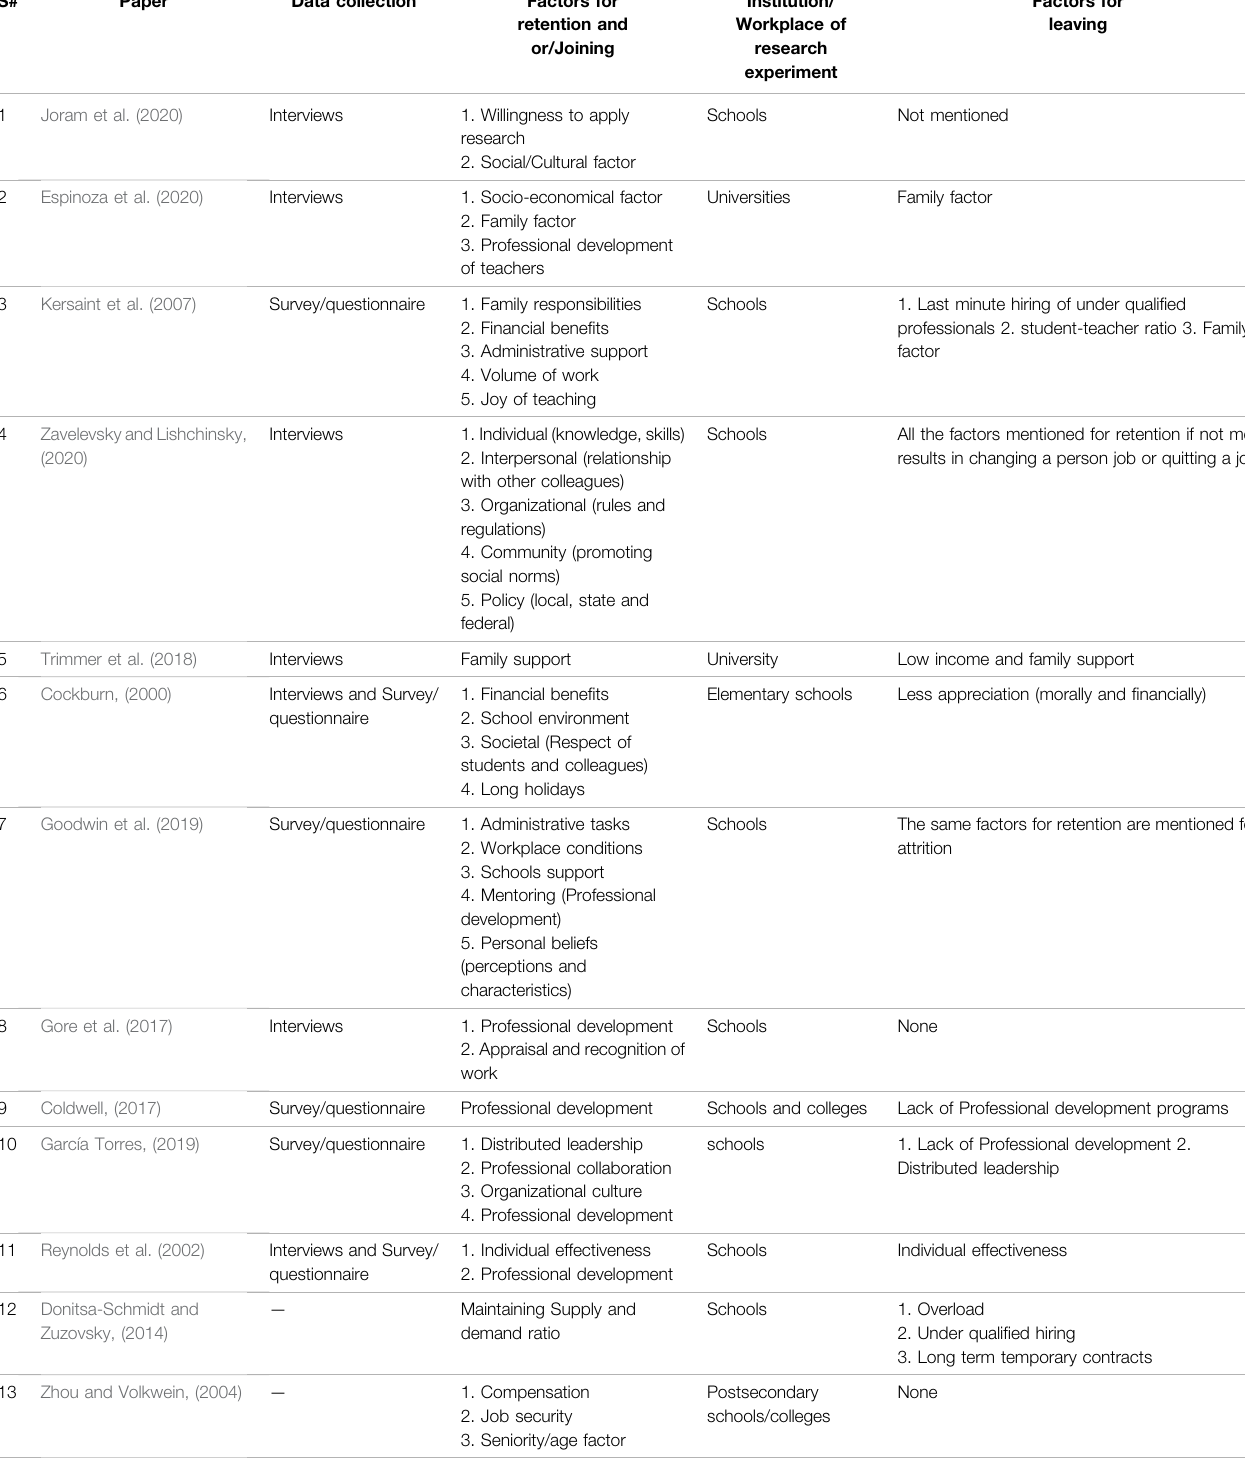
TABLE 1 | Faculty retention factors at different educational